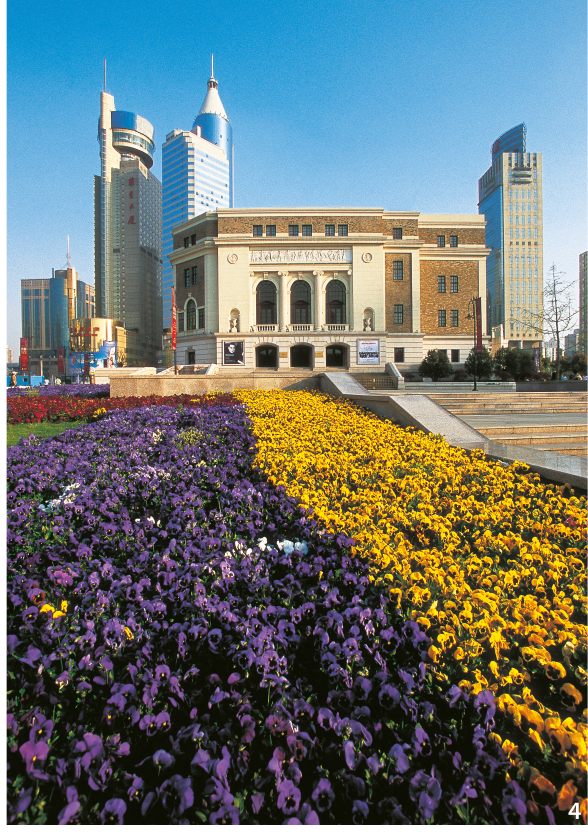
Figure 4 Shanghai Concert Hall after relocation and renovation (Source: Photograph by Xu Zhigang)